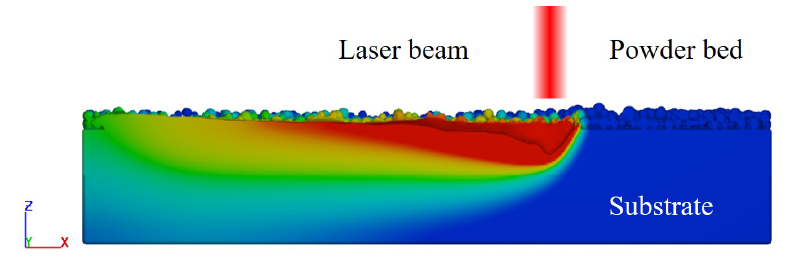
Figure 1. Thermo-fluid flow